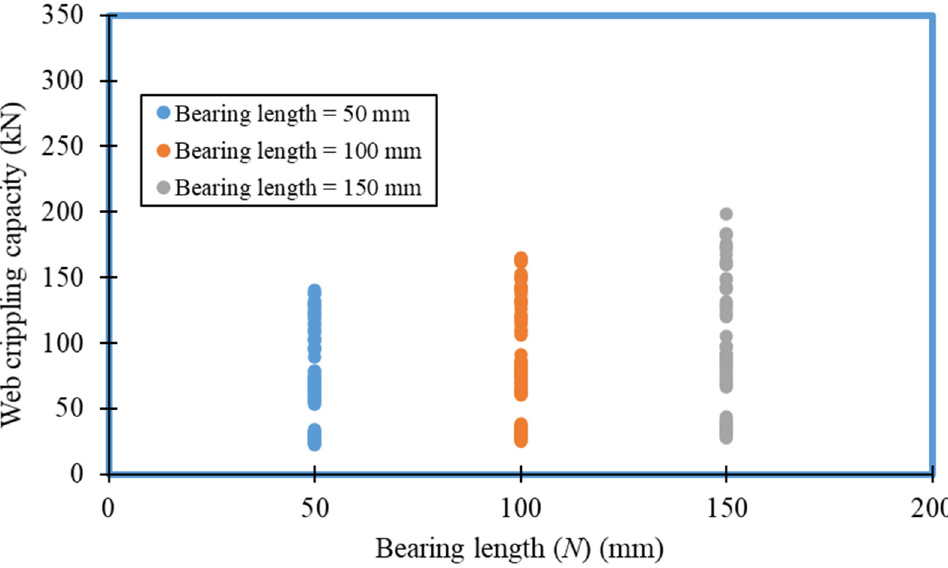
Figure 19. Effect of bearing length ( N ) on the web crippling strength.